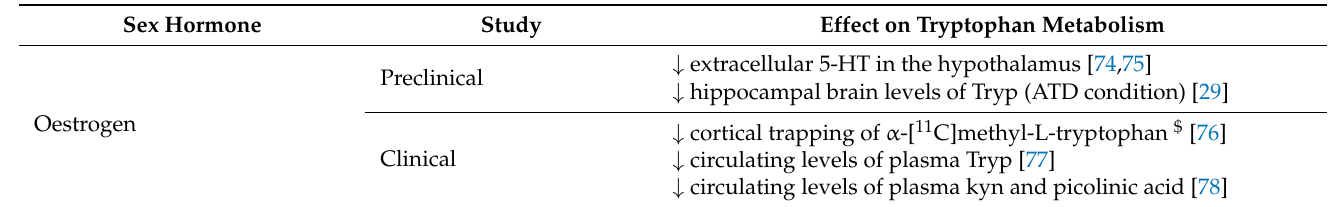
Table 3. Highlights of sex hormones in tryptophan metabolism: healthy